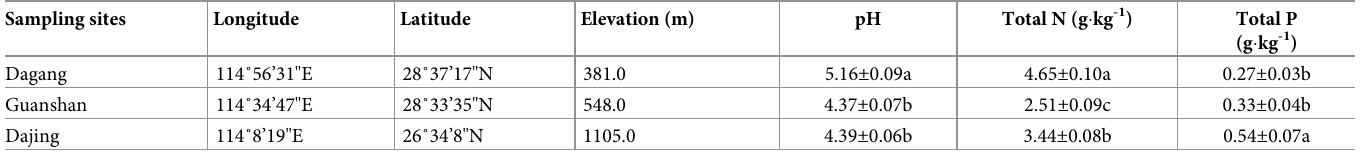
Table 1. Basic parameters and soil characteristics of the three sampling sites. Sampling